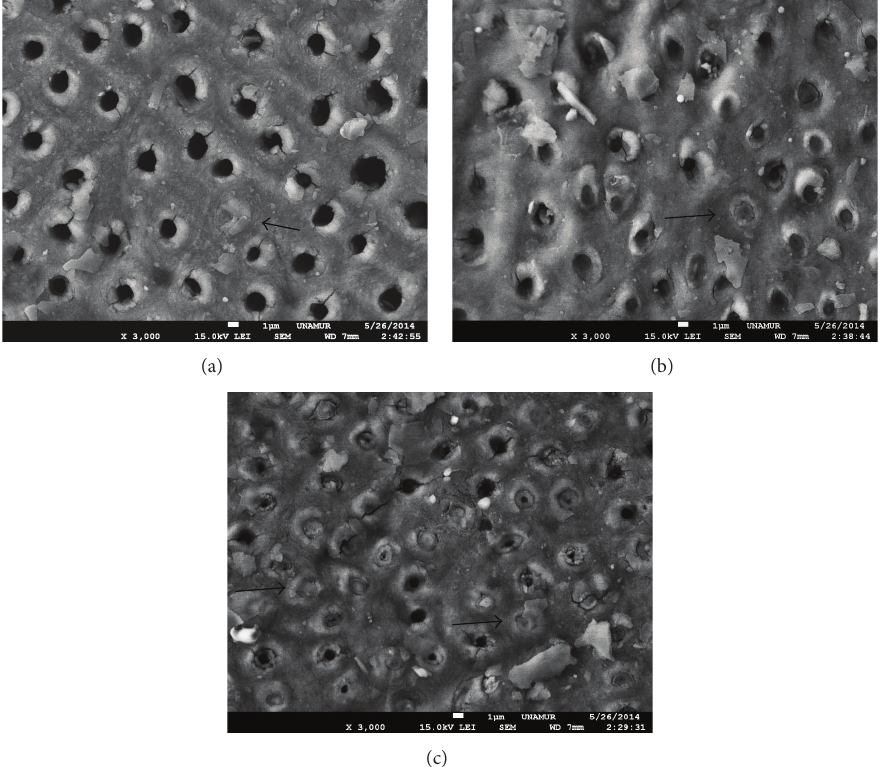
Figure 5: SEM view of Nd:YAP lased dentin treated previously with EDTA (18%). SEM view of exposed dentine with Nd:YAP laser beam at 5 W (a), 7.5W (b), and 10 W (c). We can notice a tubules narrowing specifically in (b) and (c). Arrows show some occluded tubules. Magnification: 3000x.